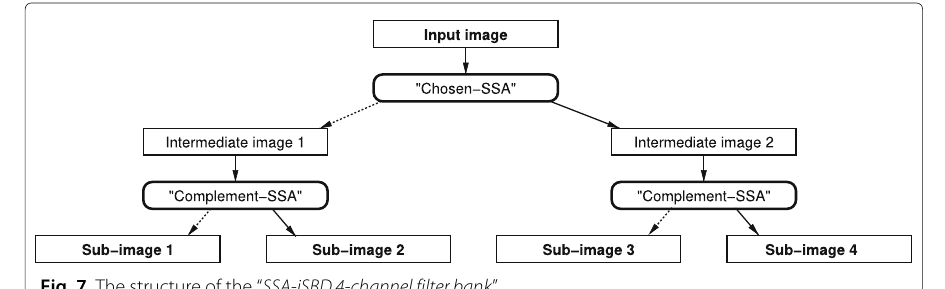
Fig. 7 The structure of the “ SSA-iSBD4-channelfilterbank ”